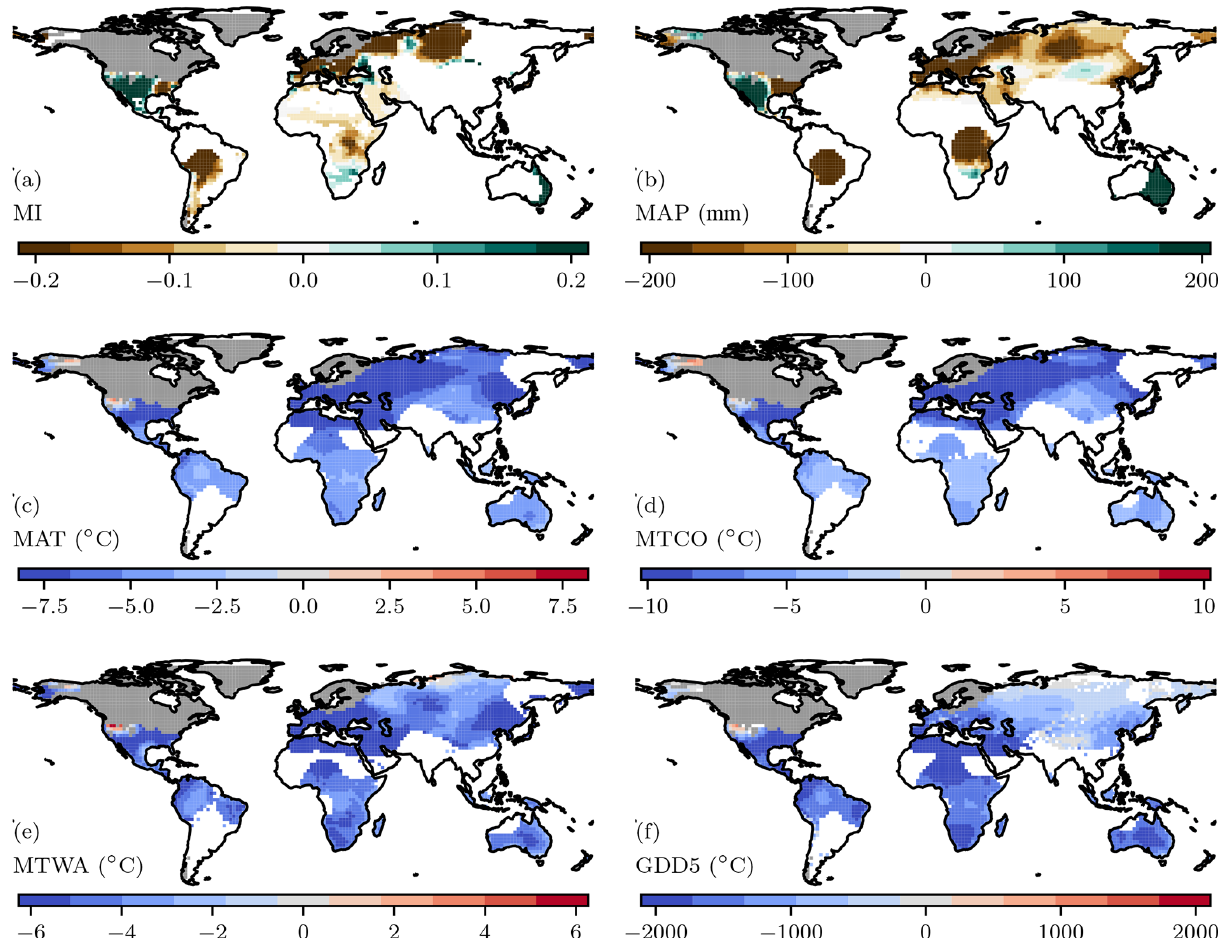
Figure 4. Analytically reconstructed climate, where areas for which the site-based data provide no constraint on the prior have been masked out. The individual plots show reconstructed (a) moisture index (MI), (b) mean annual precipitation (MAP), (c) mean annual temperature (MAT), (d) mean temperature of the coldest month (MTCO), (e) mean temperature of the warmest month (MTWA), and (f) growing degree days above a baseline of 5 ◦ C (GDD5). The anomalies are expressed relative to the long-term average (1960–1990) values from the Climate Research Unit (CRU) historical climatology data set (CRU CL v2.0 data set, New et al.,